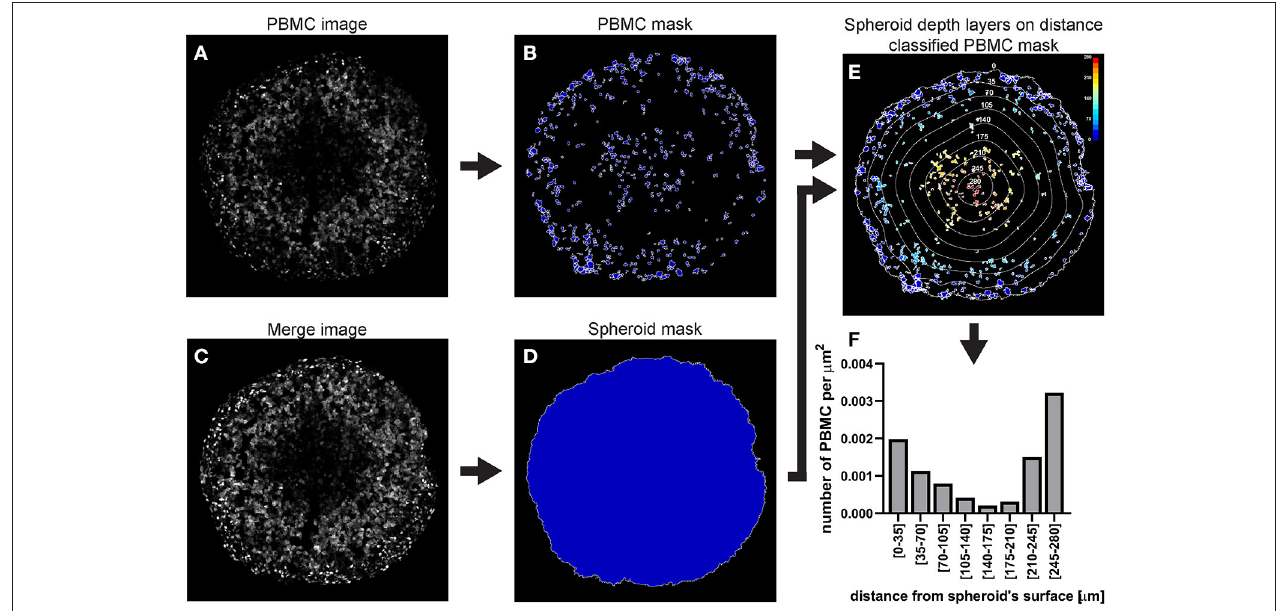
FIGURE 12 | Main steps of CellProfiler PBMC infiltration image analysis. The PBMC image (A) is used to identify the PBMC as primary objects (B) . The Merge image (C) is used to determine the spheroid outline (D) which in turn is employed to measure the distance of each PMBC from the spheroid surface (E) . The data obtained from the CellProfiler analysis can be used to generate a PBMC infiltration profile at different depths in the spheroid (F) . The colour-coded scale (E) indicates the distance from the spheroid’s surface in µ m. In (E) the numbers labelling the depth curves indicate the distance from the spheroid’s surface in µ